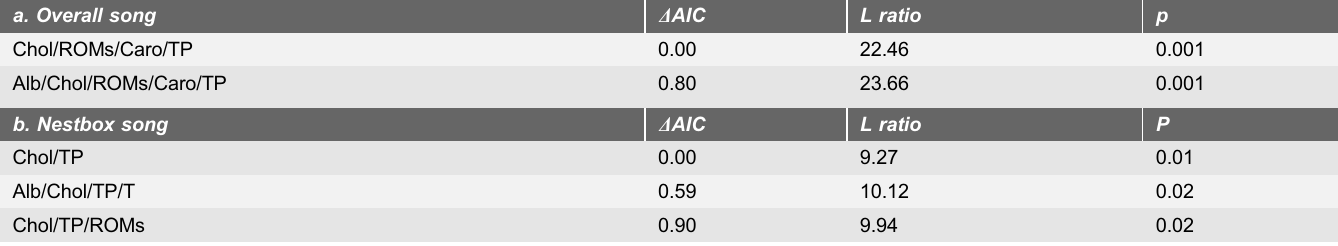
Table 1. Models related to overall song rate (a) and nestbox-oriented song rate (b) and all the physiological variables measured on day 30. a. Overall song